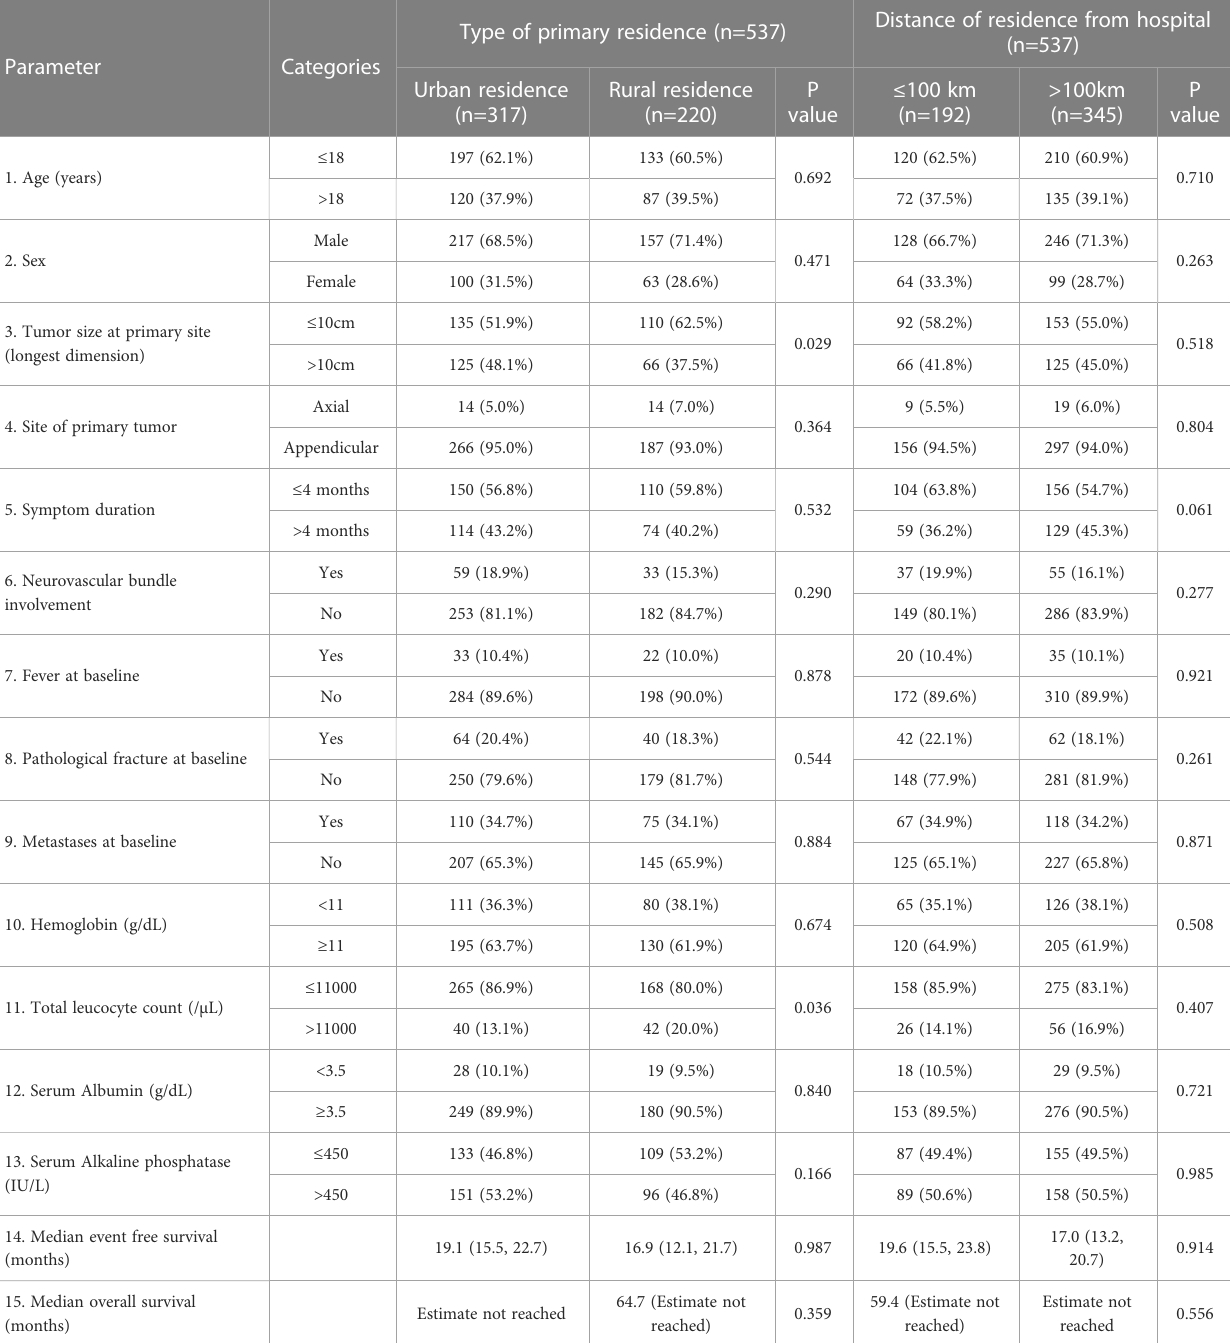
TABLE 3 Impact of sociodemographic parameters on clinical factors at presentation and survival outcomes of osteosarcoma in the whole cohort.